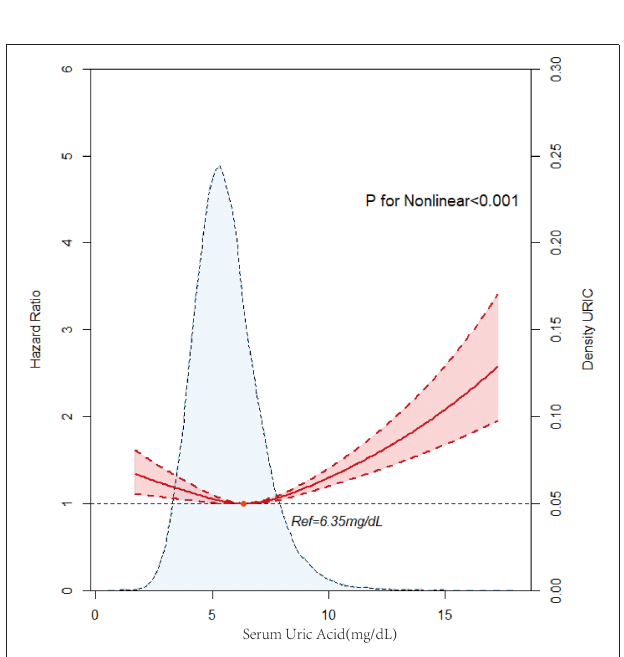
FIGURE 4 | Multivariable adjusted cubic spline model for the association between serum uric acid (SUA) level and hazard ratios (HRs) for all-cause